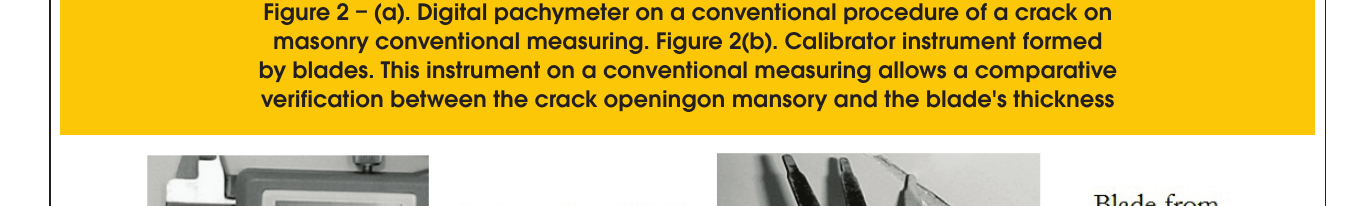
Figure 2 – (a). Digital pachymeter on a conventional procedure of a crack on masonry conventional measuring. Figure 2(b). Calibrator instrument